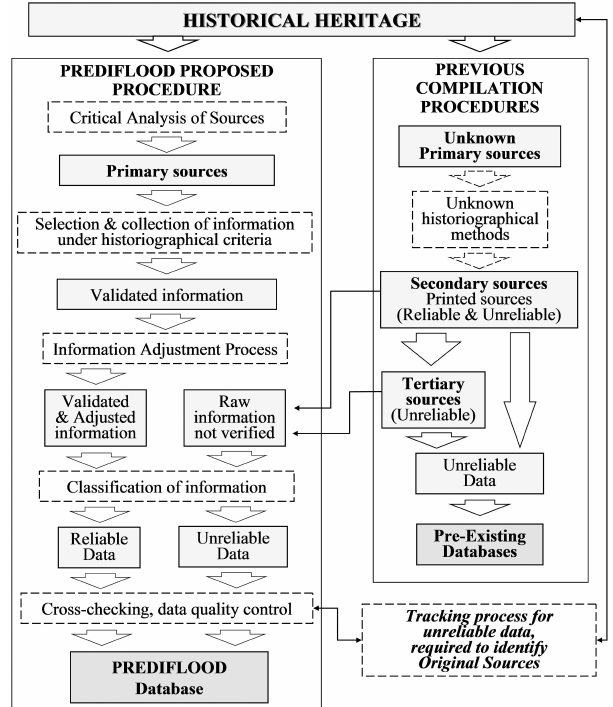
Figure 3. Overview of the methodological procedure of historical floods data collection (own